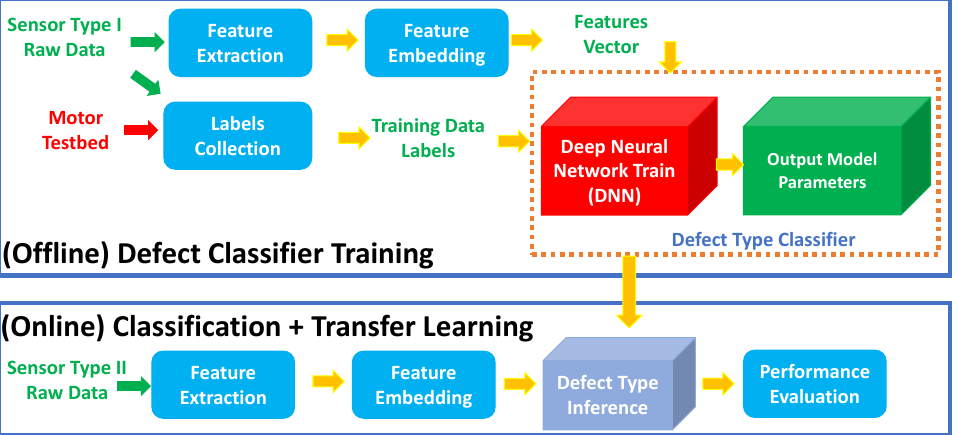
Figure 1. The proposed learning-transfer model has two modes: offline DNN sub-model training and online-mode for classifying the sensor under test after sharing knowledge (i.e., DNN’s weights and